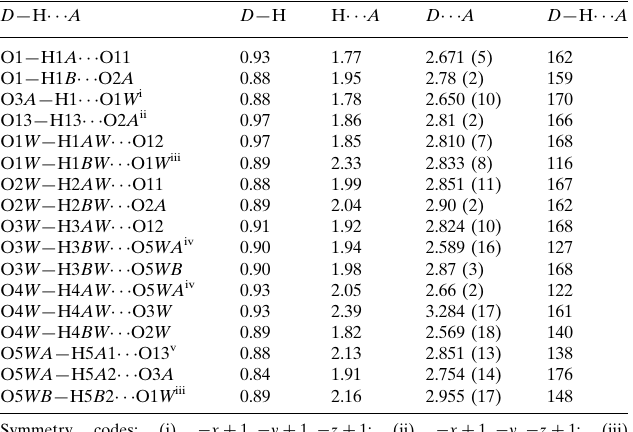
Hydrogen-bond geometry (A˚ , (cid:2)